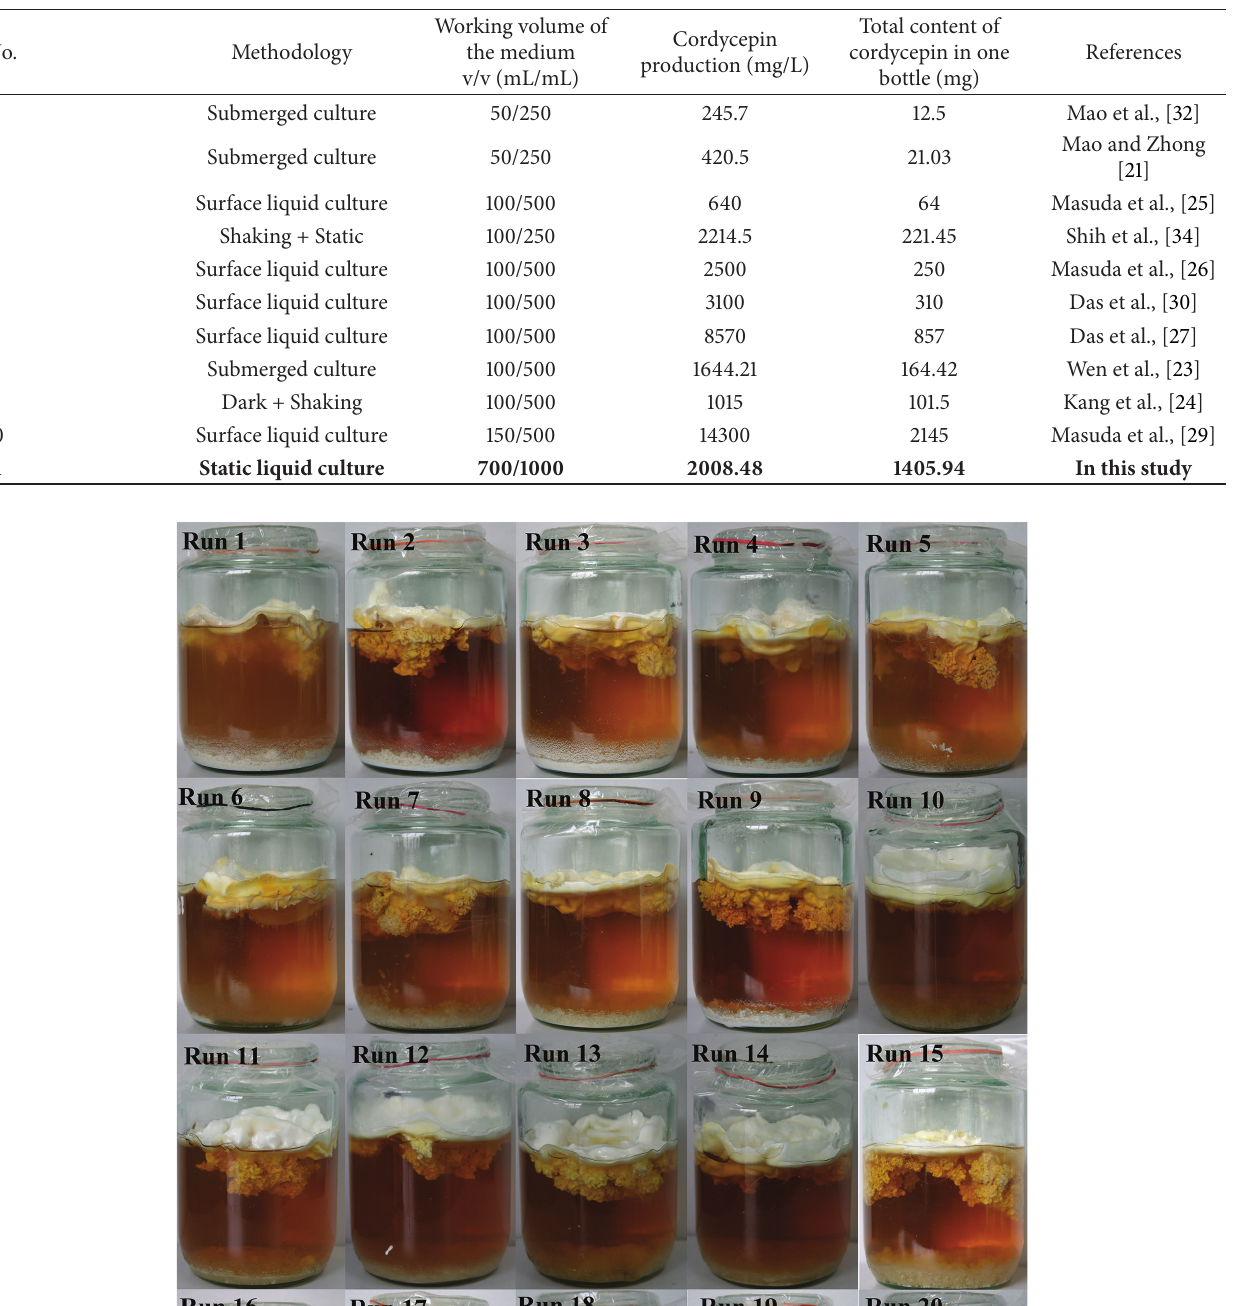
Table 10: Cordycepin production in the medium by liquid culture in different studies.